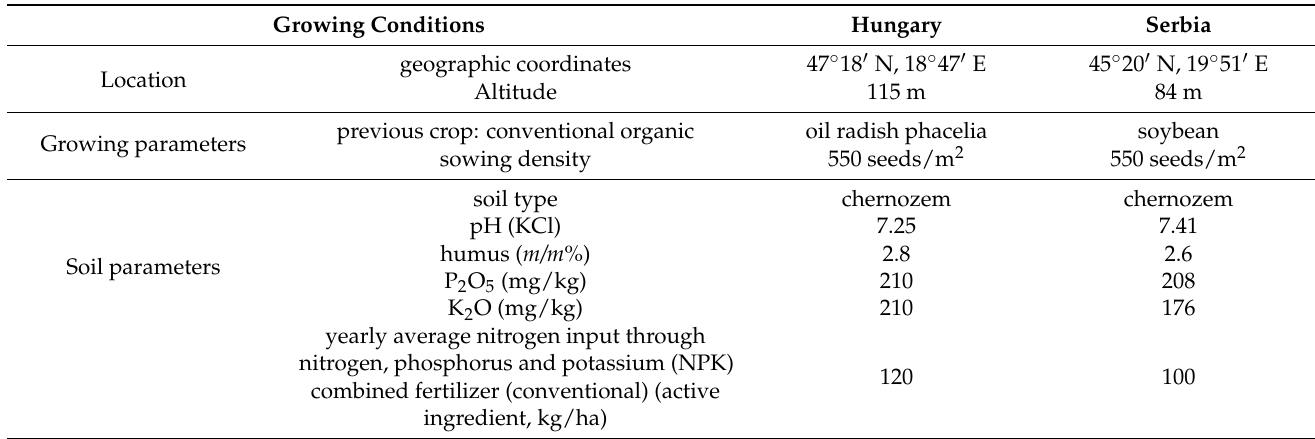
Table 2. Growing and environmental conditions of different management systems in Hungary and Serbia.